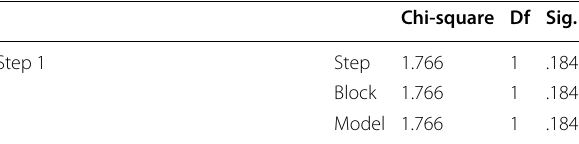
Table E: Omnibus tests of model coefficients for outcome